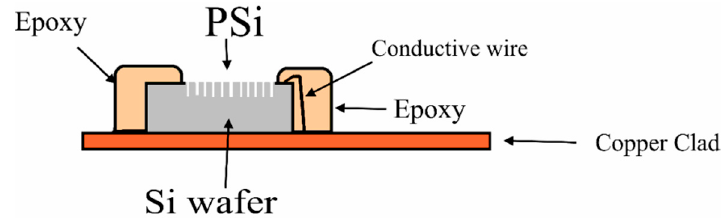
Figure 2. The fabricated PSi sensor on a copper-clad sheet.